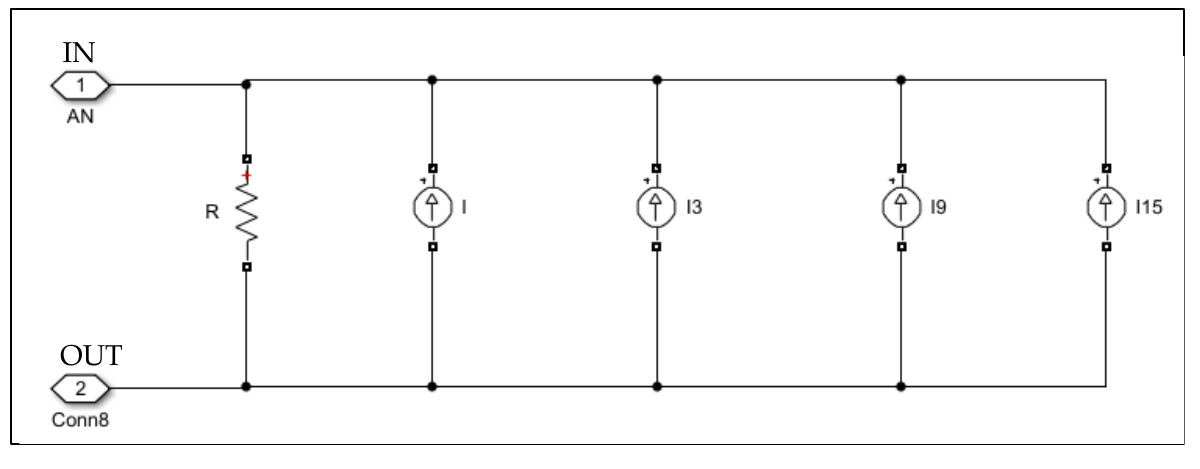
Figure 3. Harmonics current injection.